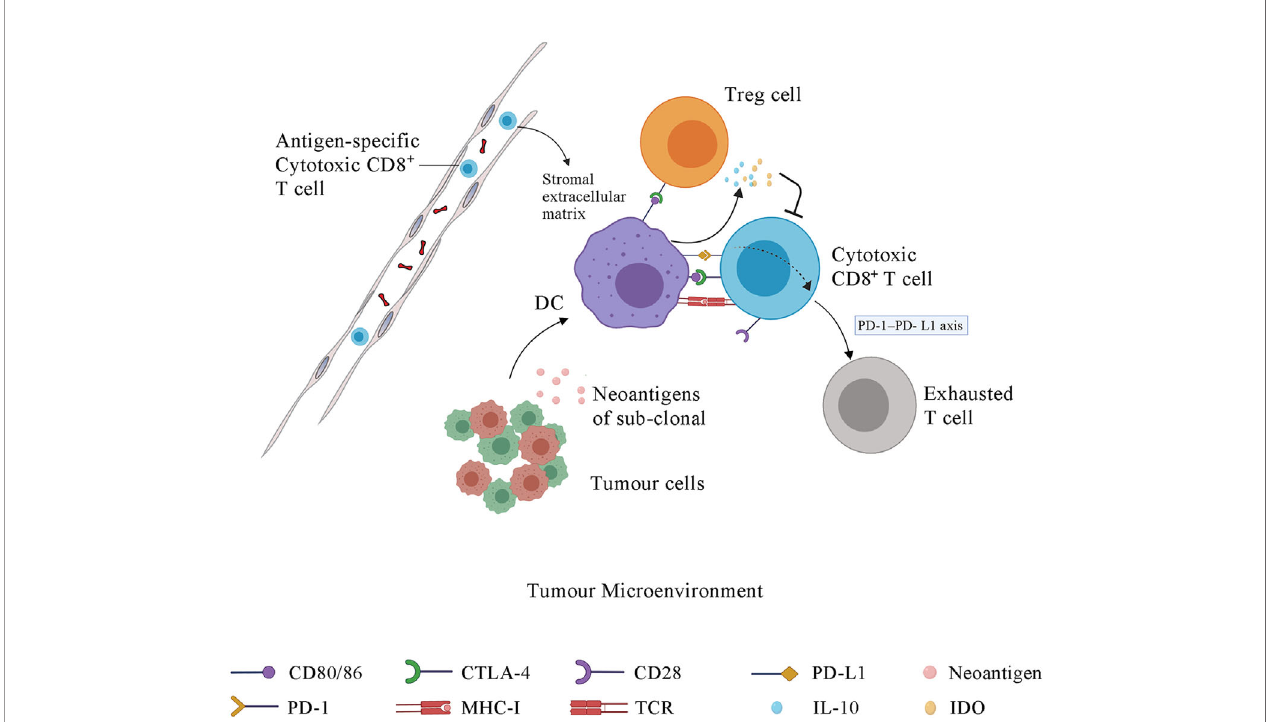
FIGURE 2 | The immune response in tumor microenvironment and the function of immune checkpoints. Some sub-clonal tumor cells release neoantigens while others do not, contributing to the immune response to only part of tumor cells and thus leading to the failure of tumor immunotherapy. Upon antigen recognition, DCs present the antigen-MHC molecules, bind to the TCR on T cell membrane and stimulate the proliferation and activation of CD4 + T cells and CD8 + T cells in lymph node. Then the antigen-speci fi c cytotoxic T cells migrate to tumor microenvironment via blood system. The stromal extracellular matrix in tumor may prevents T cell in fi ltration. CTLA-4, which is the membrane receptor of activated T cells, outcompetes CD28 for binding to the CD80/86 expressed on the DC membrane, further inhibiting the signal 2, which is essential for the maturation, proliferation, activation and survival of T cells. The interaction of PD-1 and PD-L1 promotes the differentiation and proliferation of Treg cells and induces the cytotoxic CD8 + T cells into an exhausted state. DCs under the in fl uence of CLTA-4 signal and PD-1 signal release some immunosuppressive molecules, such as IL-10 and IDO, which suppress T cells activation. IDO, indoleamine 2,3-dioxygenase; PD-1, programmed cell death protein 1; PD-L1, programmed cell death 1 ligand 1; CTLA-4, cytotoxic T-lymphocyte protein 4; DC, dendritic cell; Treg cell, regulatory T